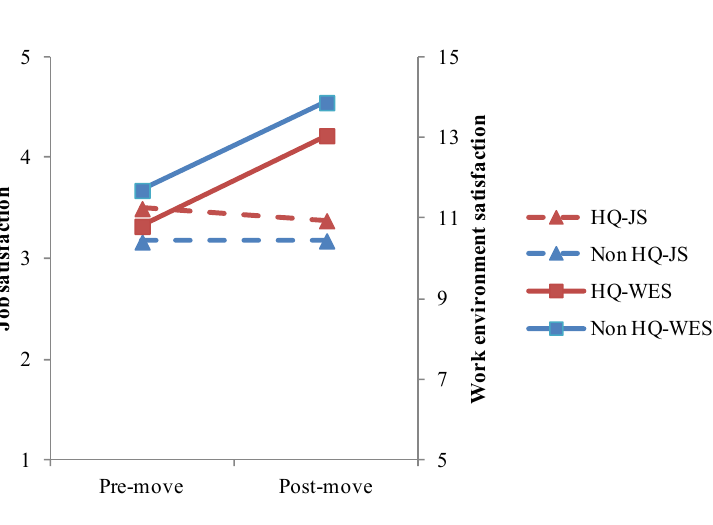
Figure 2. Change in work environment satisfaction and job satisfaction after the office